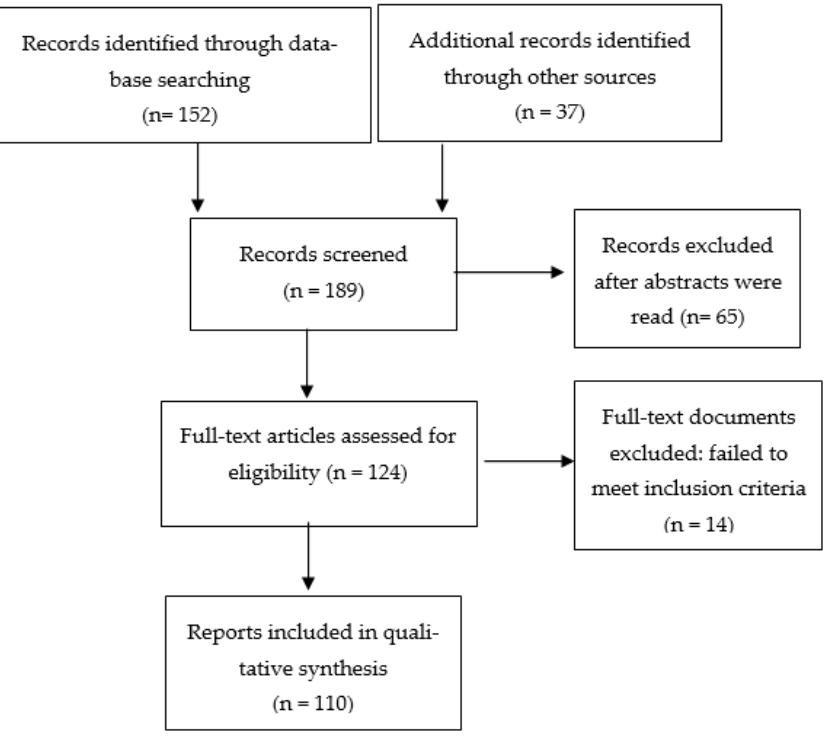
Figure 1. Flow diagram of the included